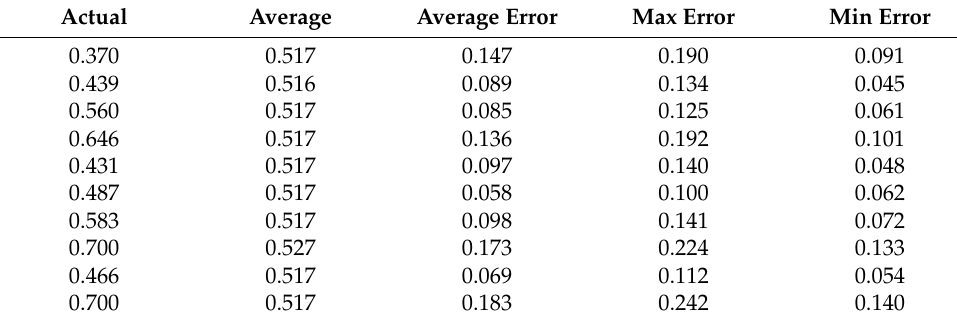
Table A202. Set 3, trials 31–40 data (actual PR